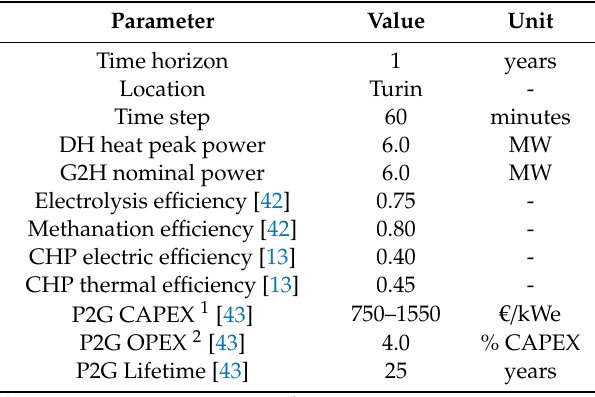
Table 2. Parameters required for scenario